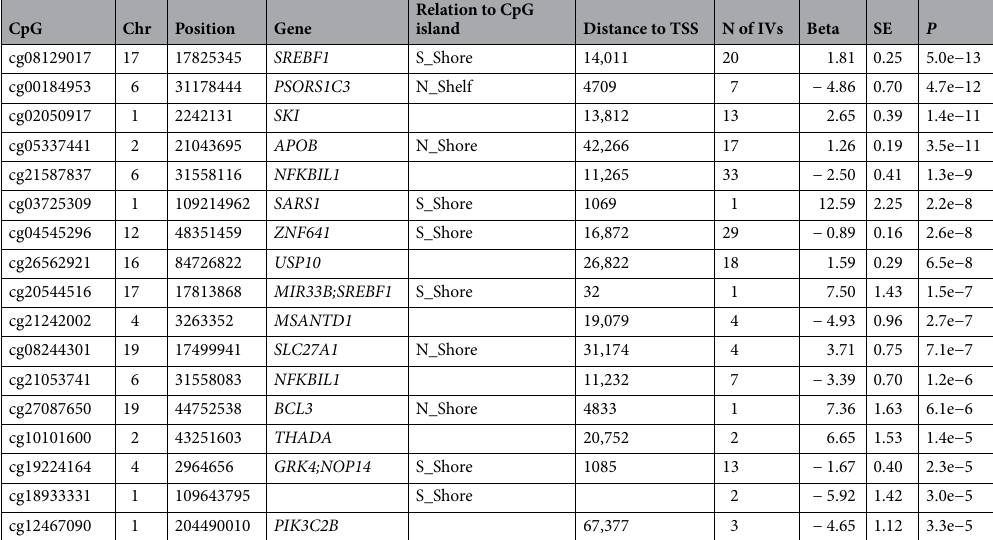
Table 3. Mendelian randomization analysis for CVD risk factor-associated CpGs (exposure) with coronary artery disease (outcome). IV: instrument variables, i.e., independent cis -mQTL variants with linkage disequilibrium R-squared < 0.1. Beta, SE, and P are derived from Mendelian randomization analysis using the inverse variance weighted (IVW) method.